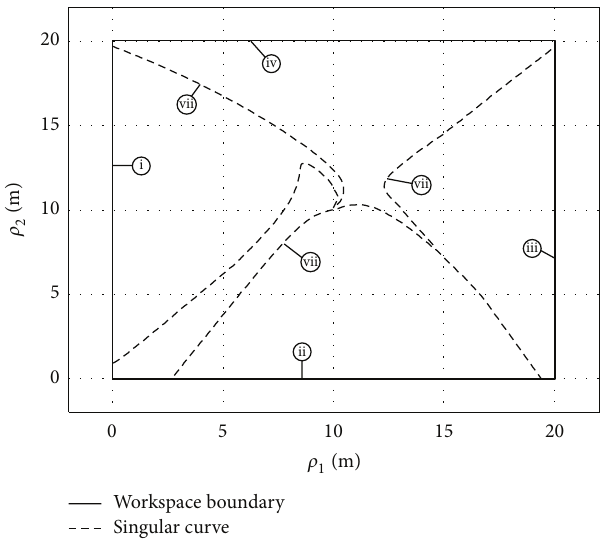
Figure 2: Actuator workspace and singular curves for the planar 4- bar tensegrity mechanism with 𝐿 = 10